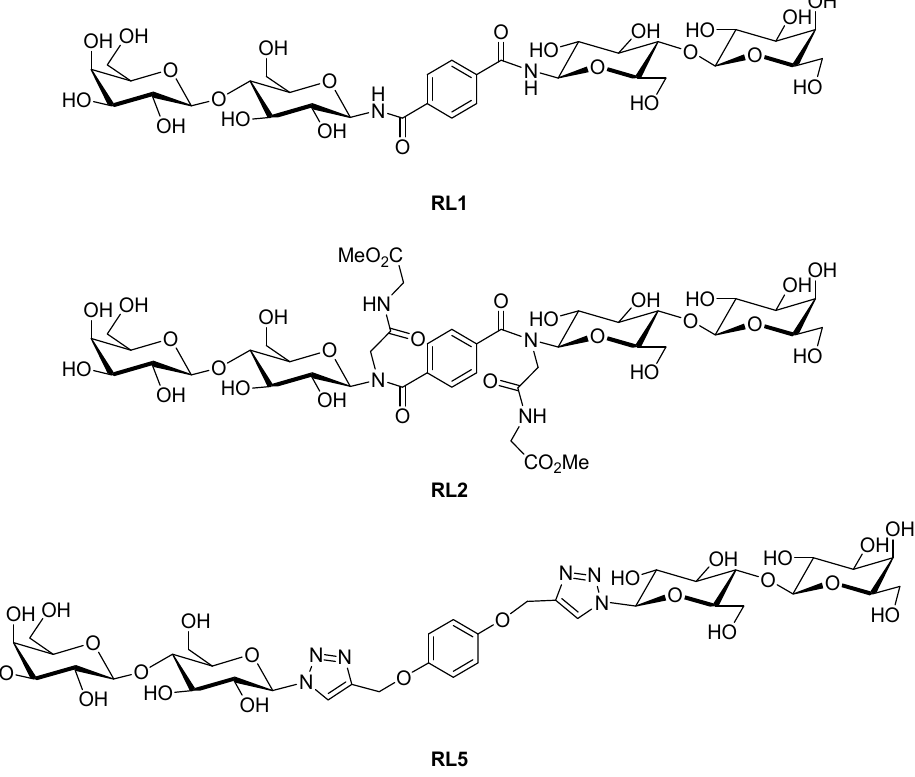
Figure 1. Chemical structure of bivalent lactosides used in this study. ( a ) RL1; ( b ) RL2 and ( c )